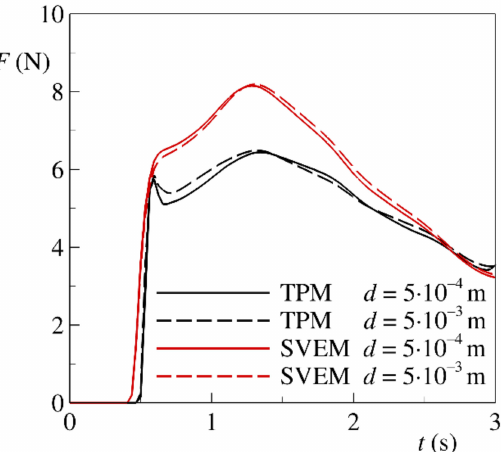
Figure 6. Temporal evolution of the impact forces for the two considered PVC diameters. SVEM vs.